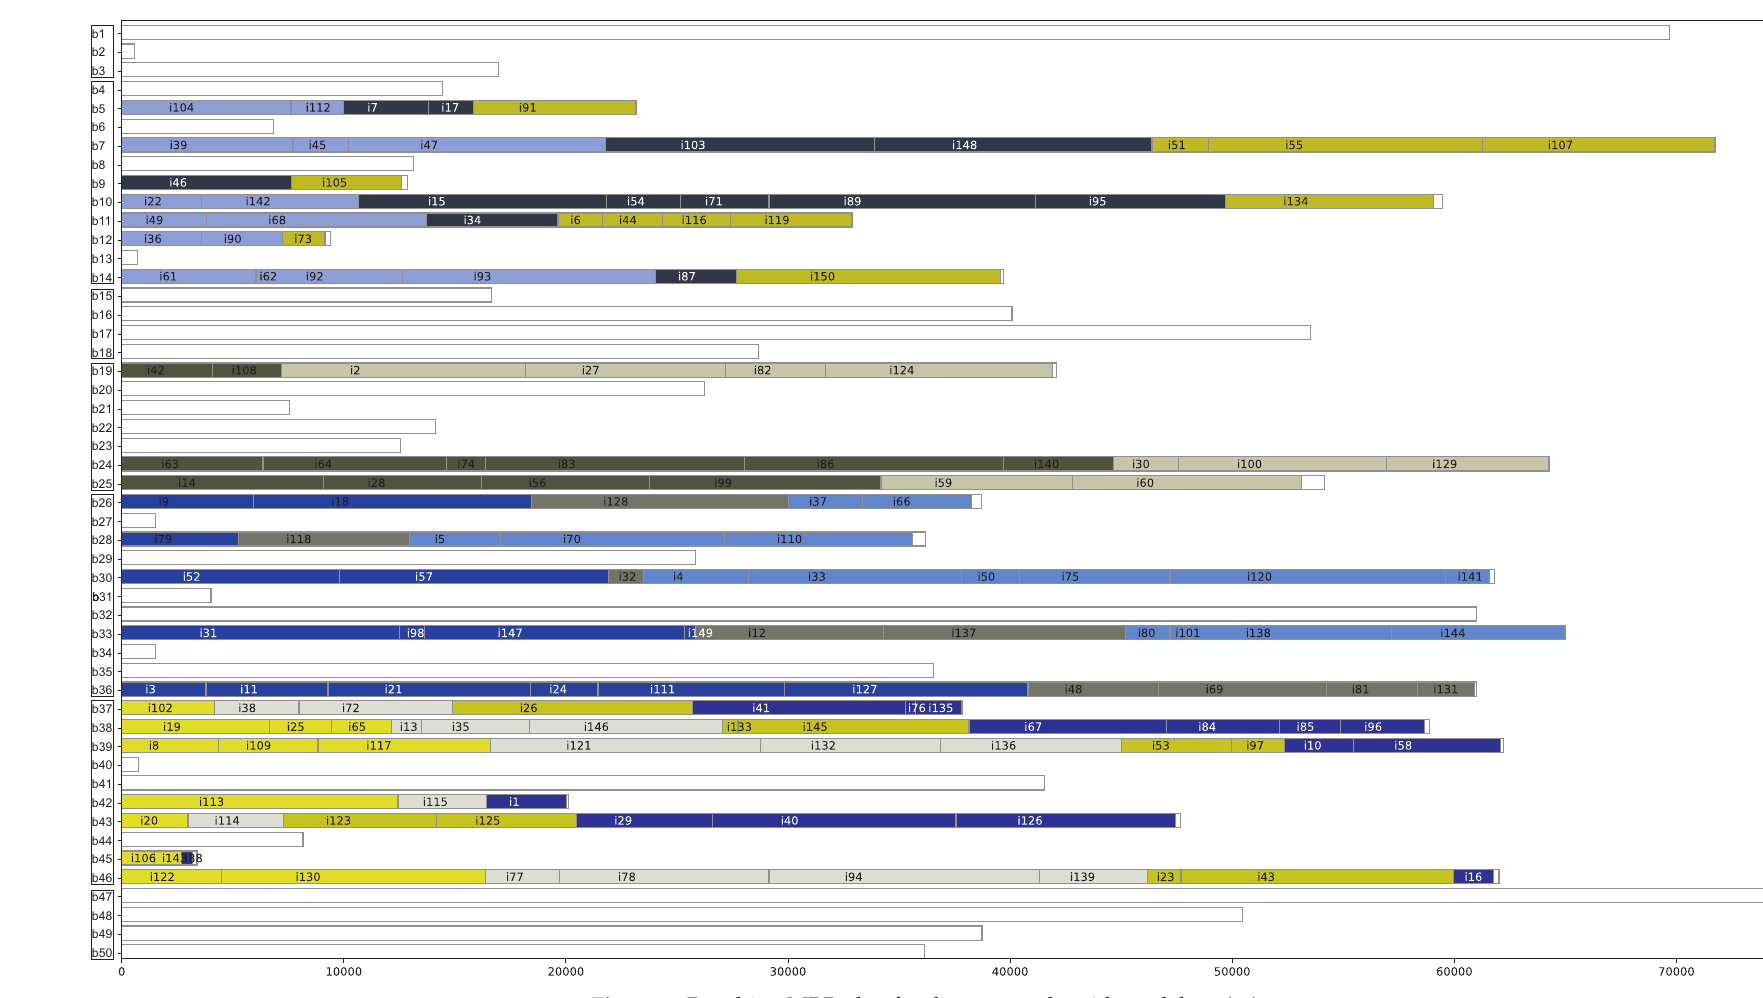
Figure 9. Resulting MRP plan for the case study with no delays ( z 2